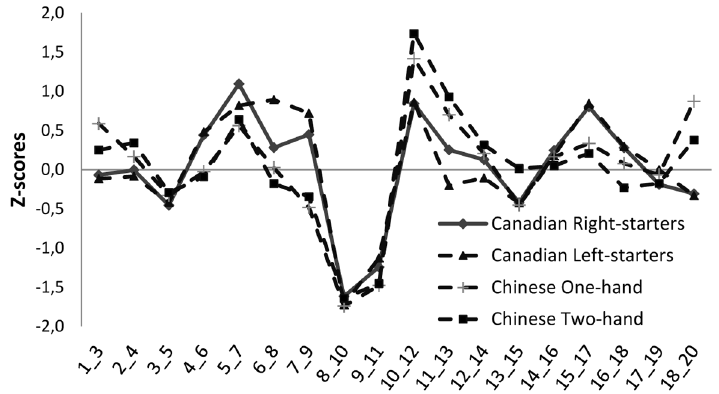
Figure 4. Standardized residual reaction-time scores across